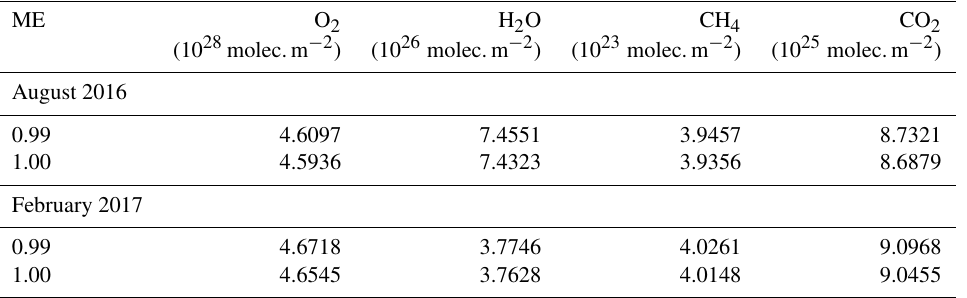
Table 2. Sensitivity study on the effect of ILS changes on the retrieval of the total gas columns. Depicted are hourly pooled data on 1 Au- gust 2016 and 15 February 2017 around solar noon, corresponding to solar elevation angles of 60 and 30 ◦ . The resulting ILS dependency of XCO 2 is − 0.16% and − 0.19% for 60 and 30 ◦ SEA, for a 1% ME increase. XCH 4 increases by 0.10% (0.09%).